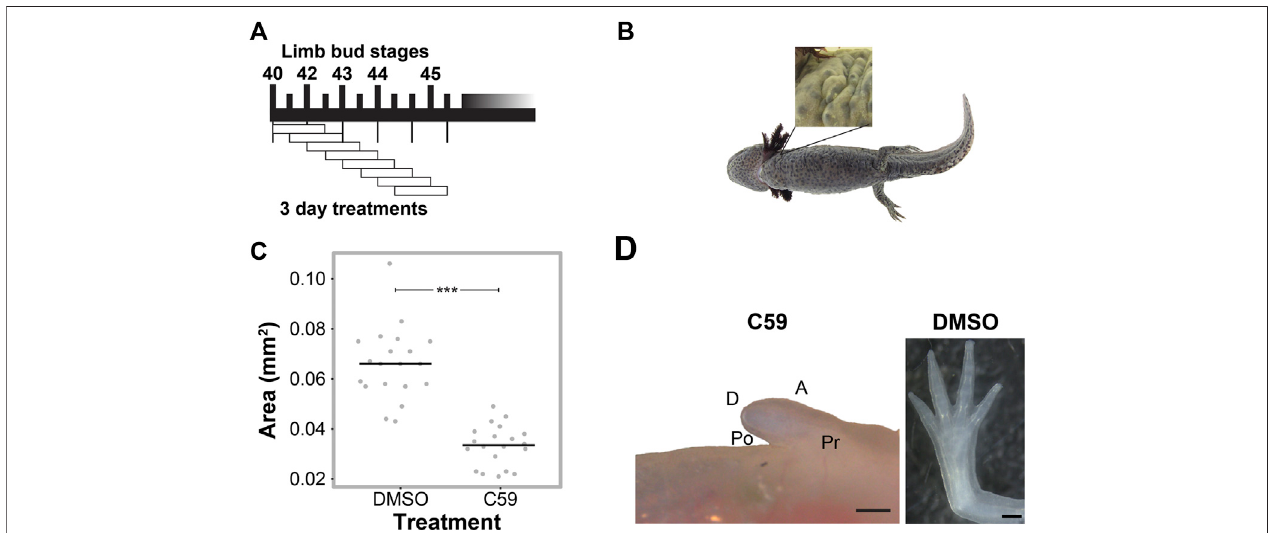
FIGURE 2 | C59 treatment of developing axolotl limbs. (A) Treatment scheme with 10 µM C59 for 3 days intervals. Animals were allowed to grow inde fi nitely after treatment. (B) Image of a C59-treated stage 40 animal 2 years after treatment. The zoomed-in panel shows a complete lack of a limb. (C) Graph showing inhibition of limb bud outgrowth after 7 days of 5 μ M C59 treatment starting at stage 42. Two-tailed Student ’ s t-test *** p < 0.0001. n = 20 embryos per group. (D) An example of a permanent limb defect after 7 days of C59 treatment starting at stage 42. Left image shows a C59-treated limb 12 weeks after treatment compared to a control limb on the right. Po is posterior, D is distal, A is anterior, and Pr is proximal. Scale bars in are 500 µM.